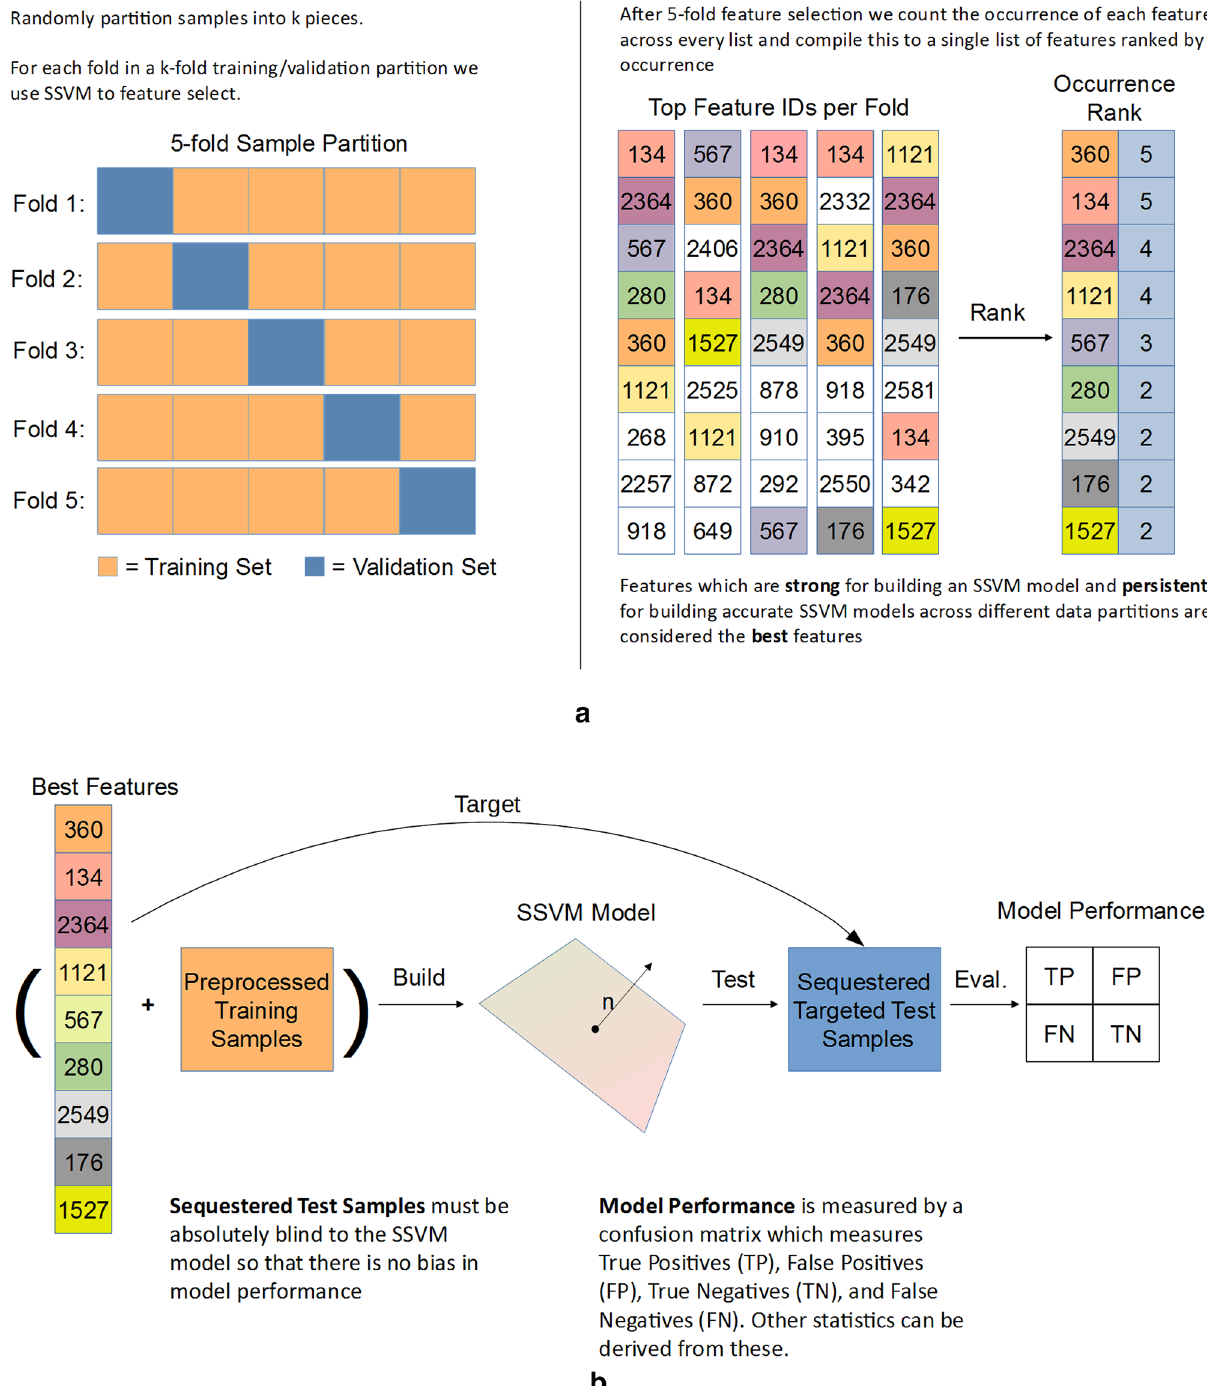
Figure 5. ( a ) Diagram of k FFS. ( b ) Diagram of building the final